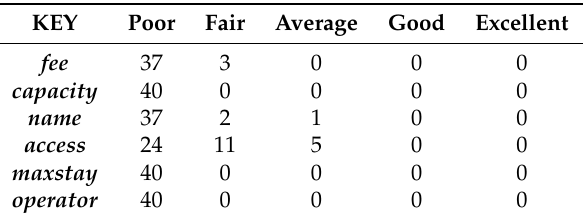
Table 9. Summary of compliance of all cities with suggested tag key combinations for the target tag amenity=parking . KEY Poor